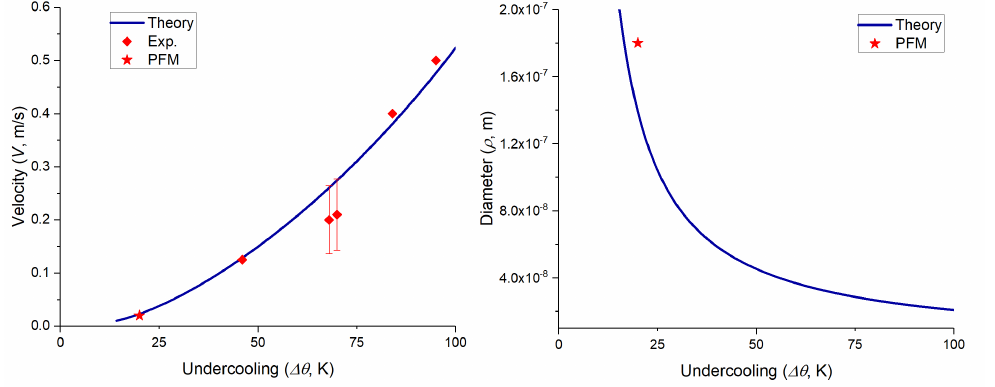
Figure 3. Dendrite tip velocity V and diameter ρ as functions of the melt undercooling ∆ θ for the alloy Ni 98 Zr 1 Al 1 . The curves represent the theory under consideration. Experimental and PFM points are taken from Galenko et al.